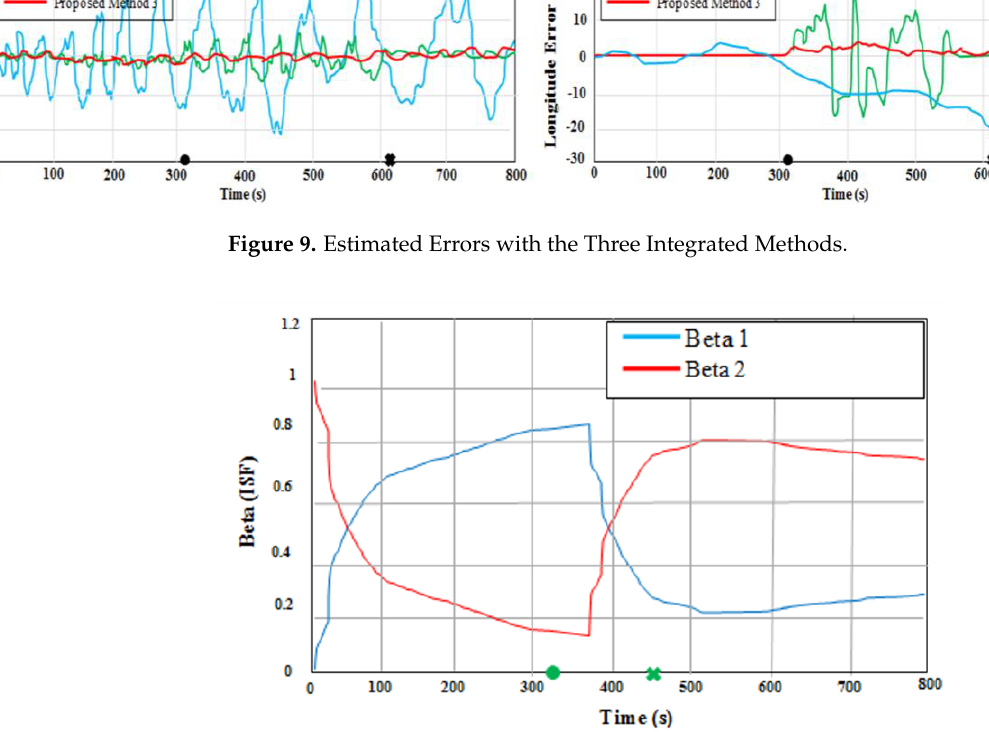
Figure 11. Estimated trajectories with the three integrated methods.